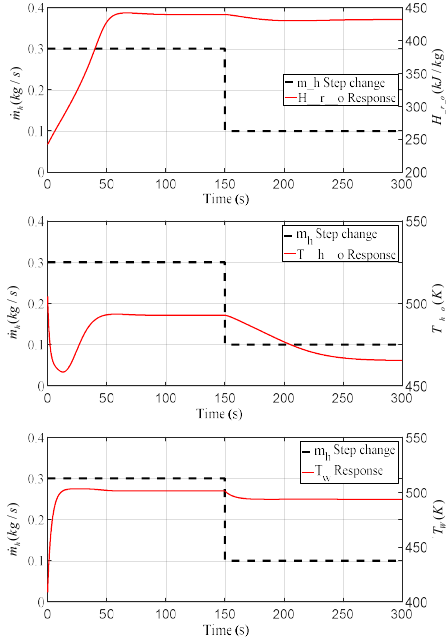
Figure 6. Response of H _ r _ o , T _ h _ o , T W with respect to